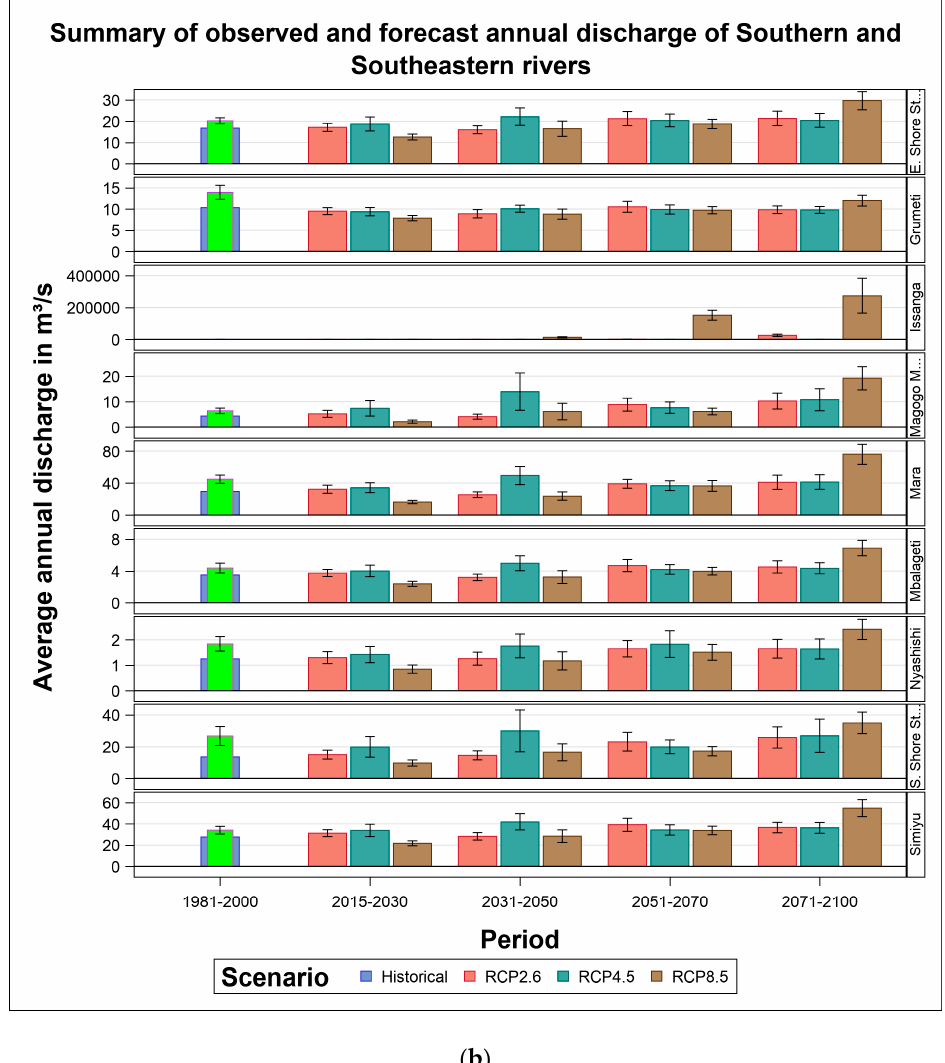
Figure 6. ( a ) Projected average annual river discharge in relation to rainfall and ( b ) summary of observed (historical) and projected average annual discharge for rivers flowing from the south and south eastern parts of the Lake Victoria Basin for the 2030s, 2050s, and 2070s under the RCP 2.6, 4.5, and 8.5 scenarios. The bright green bar is the average of the observed historic series whereas the wider medium slate blue bar is the value for the historic series predicted by the fitted model.